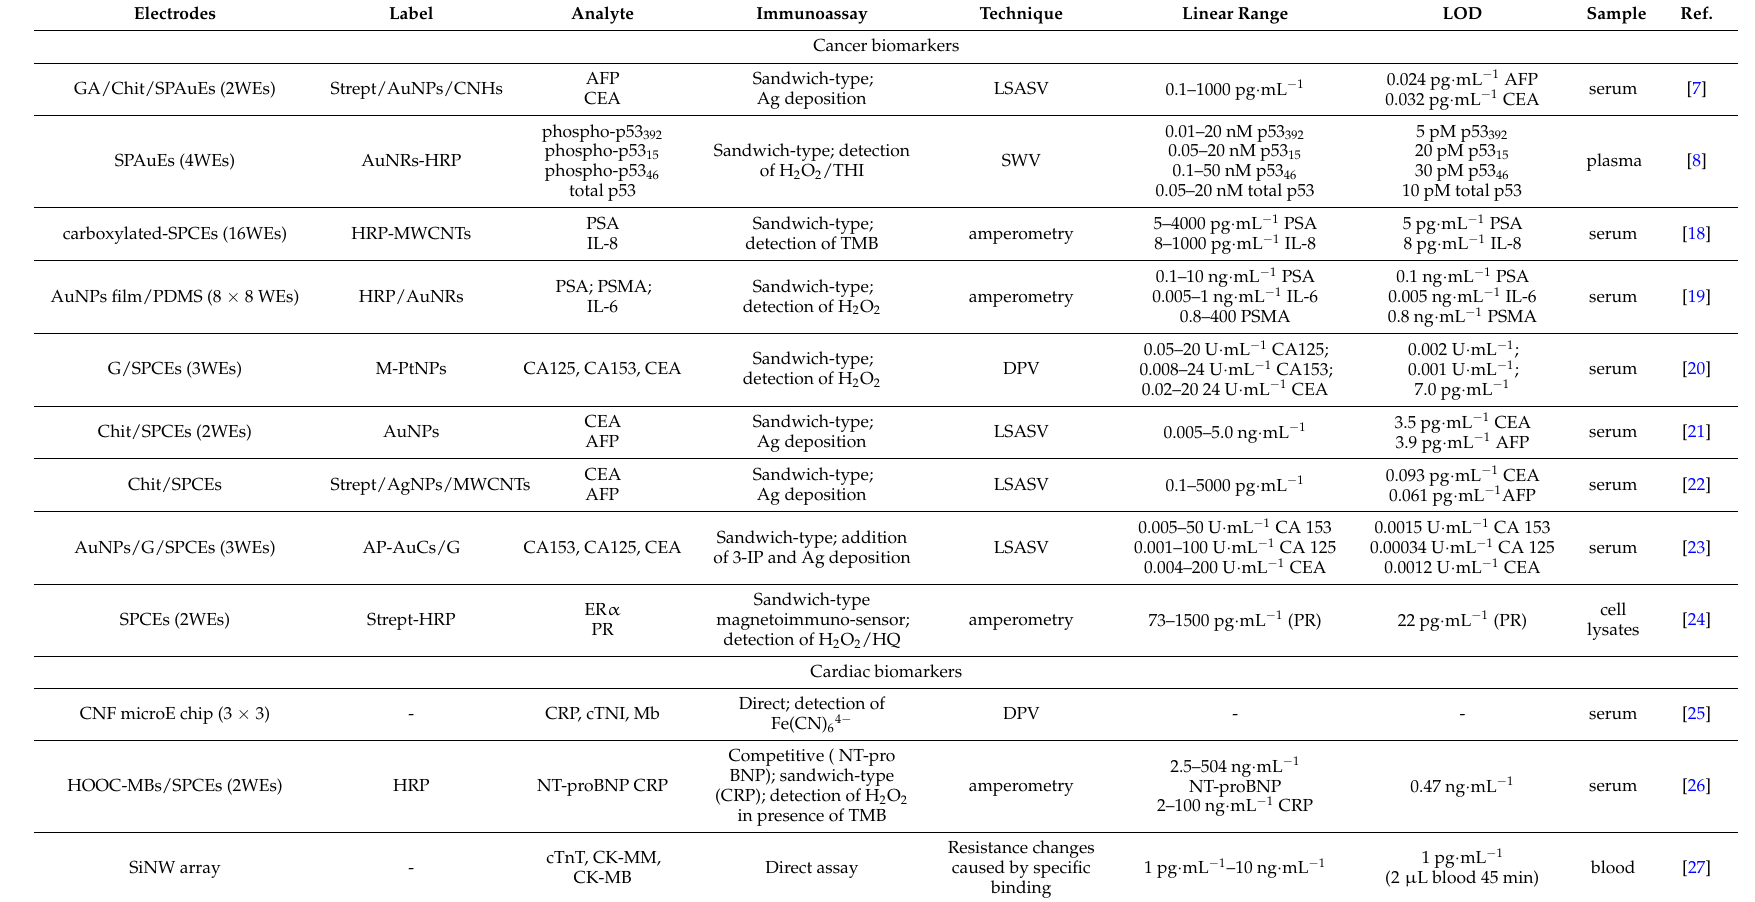
Table 1. Multiplexed electrochemical immunosensors involving electrode